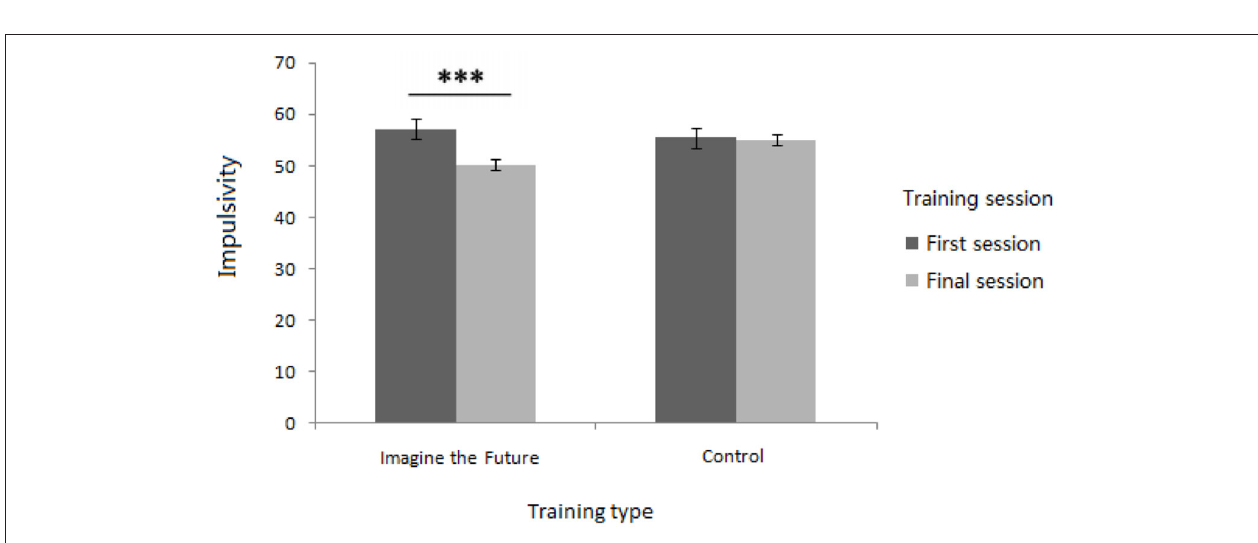
FIGURE 2 | Interaction between the training session and training type for impulsivity scores (includes mean and SD; ***means p < 0.001).